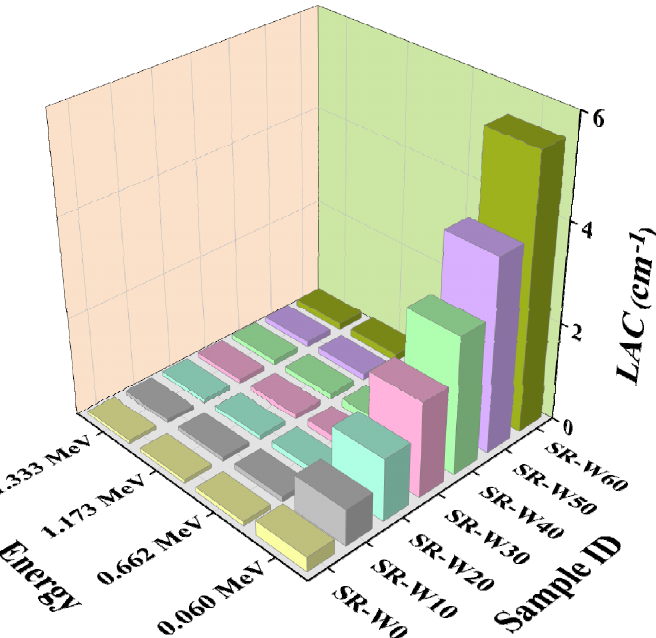
Figure 9. Pictorial presentation of the LAC of prepared silicone rubber (SR-W) systems with the function of energy.